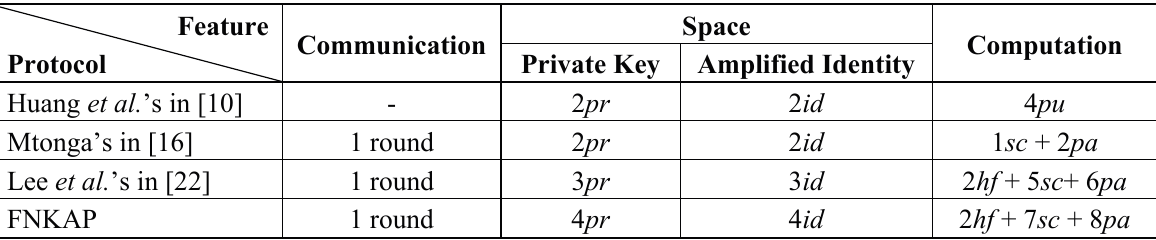
Table 3. Performance comparison. pr , private key with a length of at least 160 bits; id , amplified identity with a length of at least 128 bits; hf , hash function; pu , public-key operation; sc , scalar multiplication; pa , pairing